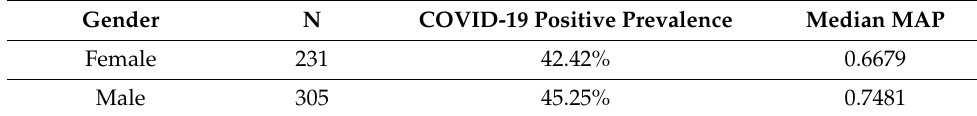
Table 6. MAP performance calculated for each gender.